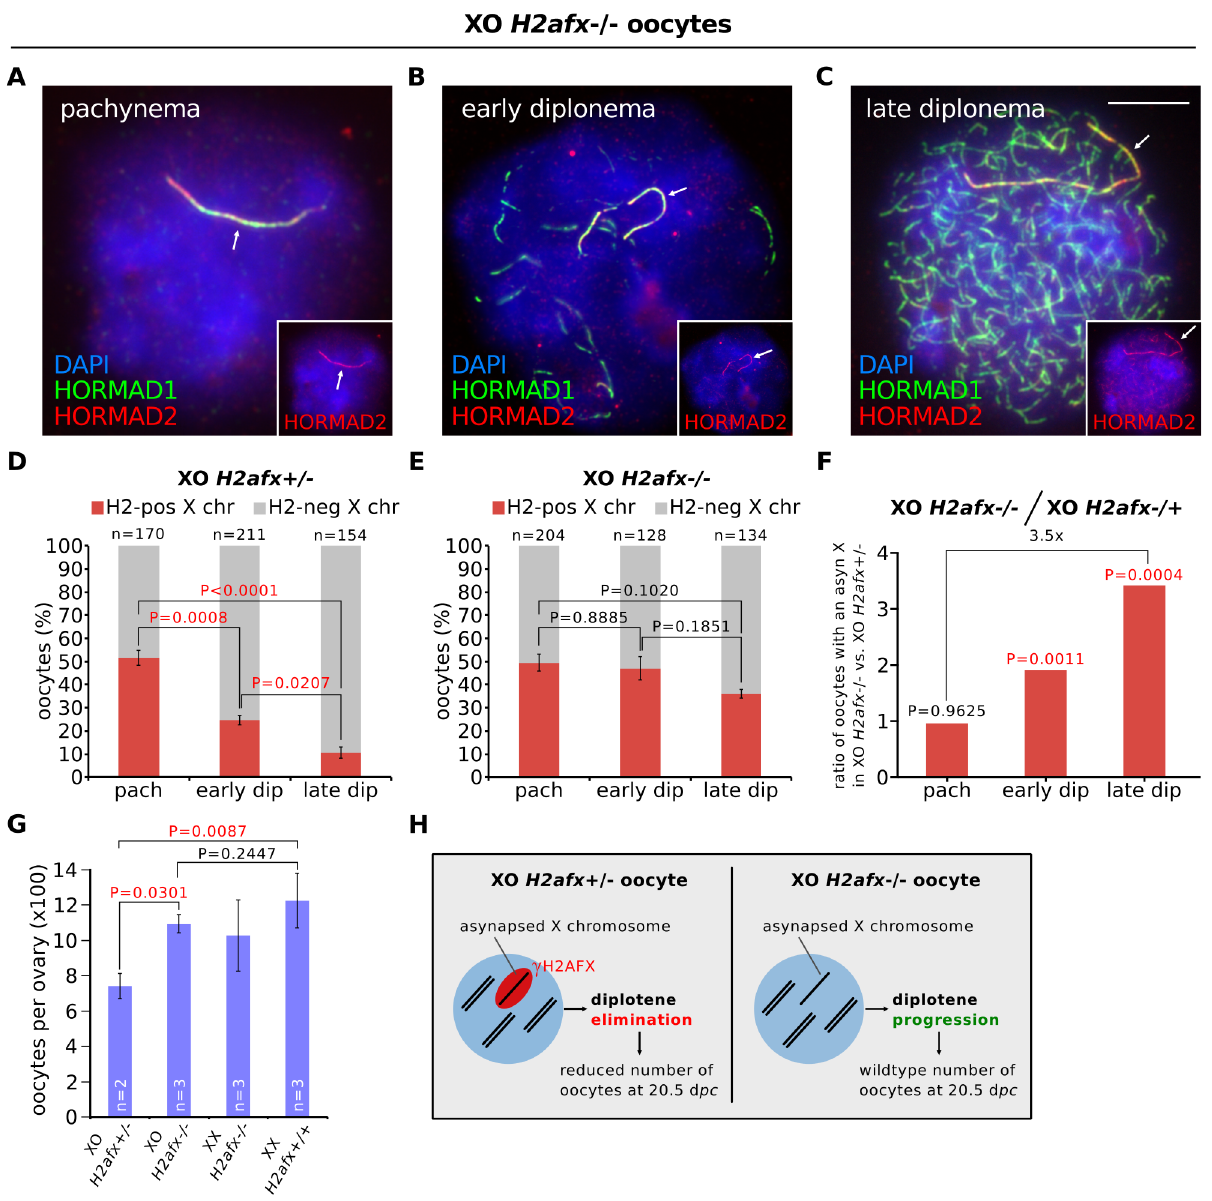
Fig 3. H2afx deletion reverses perinatal oocyte losses in XO females. ( A ) Pachytene XO H2afx-/- oocyte with an asynapsed X chromosome (arrow; marked by HORMAD1, green, and HORMAD2, red and inset). ( B ) Early diplotene XO H2afx -/- oocyte, showing intermediate levels of desynapsis (HORMAD1-only positive axes, green) and an asynapsed X chromosome (arrow; marked with both HORMAD1 and HORMAD2, inset). ( C ) Late diplotene XO H2afx -/- oocyte, showing extensive desynapsis and an asynapsed X chromosome (arrow). Scale bar represents 10 μ m. ( D ) Mean percentage ( ± s.e.m.) of XO H2afx+/- oocytes with a HORMAD1/2 double-positive X chromosome between pachynema and late diplonema at 19.5 d pc . Statistics were performed as in Fig 1. ( E ) Mean percentage ( ± s.e.m.) of XO H2afx-/- oocytes with a HORMAD1/2 double-positive X chromosome between pachynema and late diplonema at 19.5 d pc . No statistically significant difference was found between means at pachynema and late diplonema (Tukey ’ s test). ( F ) Enrichment of oocytes with an asynapsed X chromosome in XO H2afx-/- compared to XO H2afx+/- between pachynema and late diplonema. Enrichment was defined as the ratio of the mean percentage of oocytes with an asynapsed X in XO H2afx-/- versus XO H2afx+/- control, using data from part (D) and (E). ( G ) Mean number ( ± s.e.m.) of oocytes in XO and XX, ovaries with varying doses of H2afx , XO H2afx-/- ,XX H2afx+/- and XX H2afx+/+ at 20.5 d pc . n is the number of non-littermate ovaries analyzed. Tukey multiple comparison tests. ( H ) Summary showing the importance of H2AFX in XO oocyte elimination.